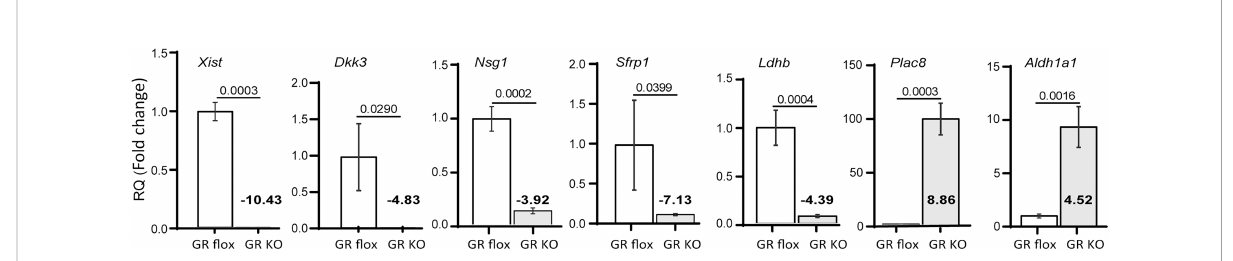
FIGURE 4 Validation of RNA-Seq data by qRT-PCR. RNA samples isolated from GR cKO and GR- fl oxed MSCs were analysed for the expression of Xist and indicated genes whose expression was shown to be up- or downregulated in GR cKO cells. Numbers in bold are the results from RNA-Seq analysis. qRT-PCR experiments were performed 3 times with similar results. PCR reactions were performed in triplicates. t -test, p values are